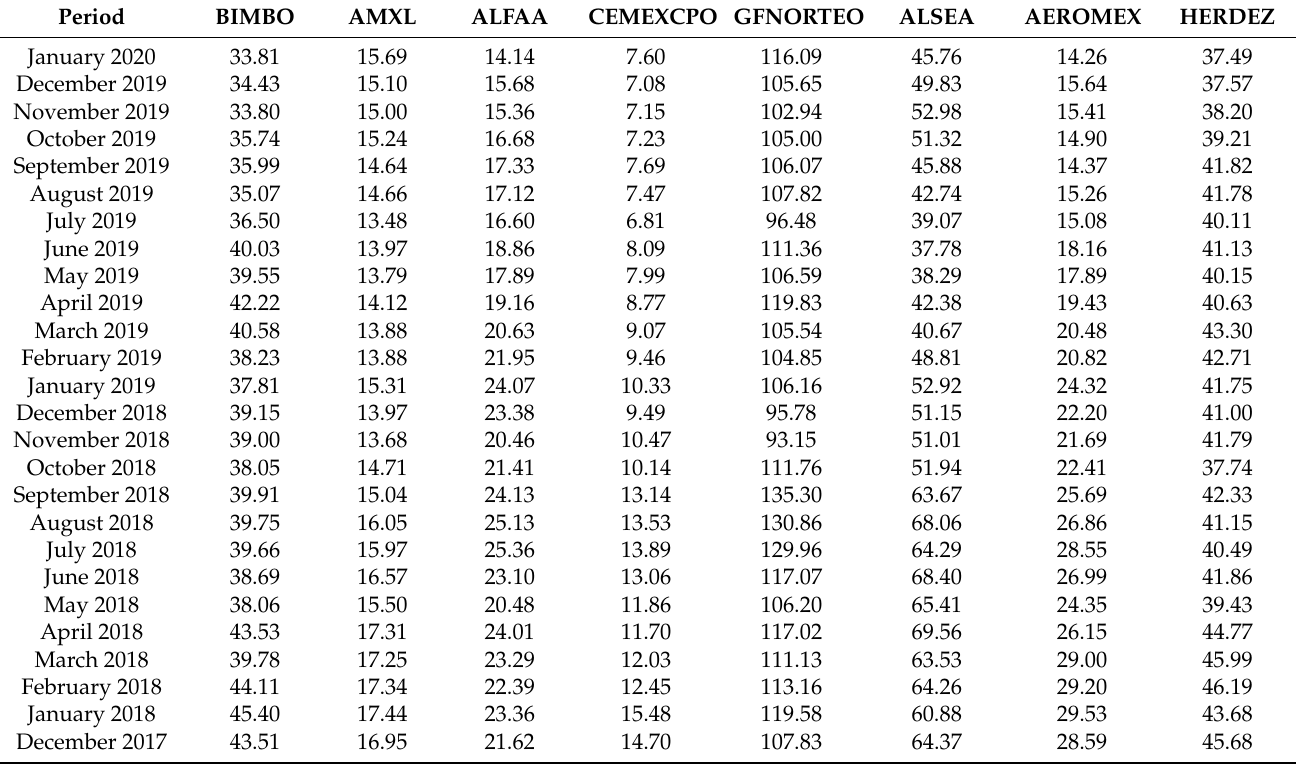
Table 2. Selected stocks with monthly close return values.